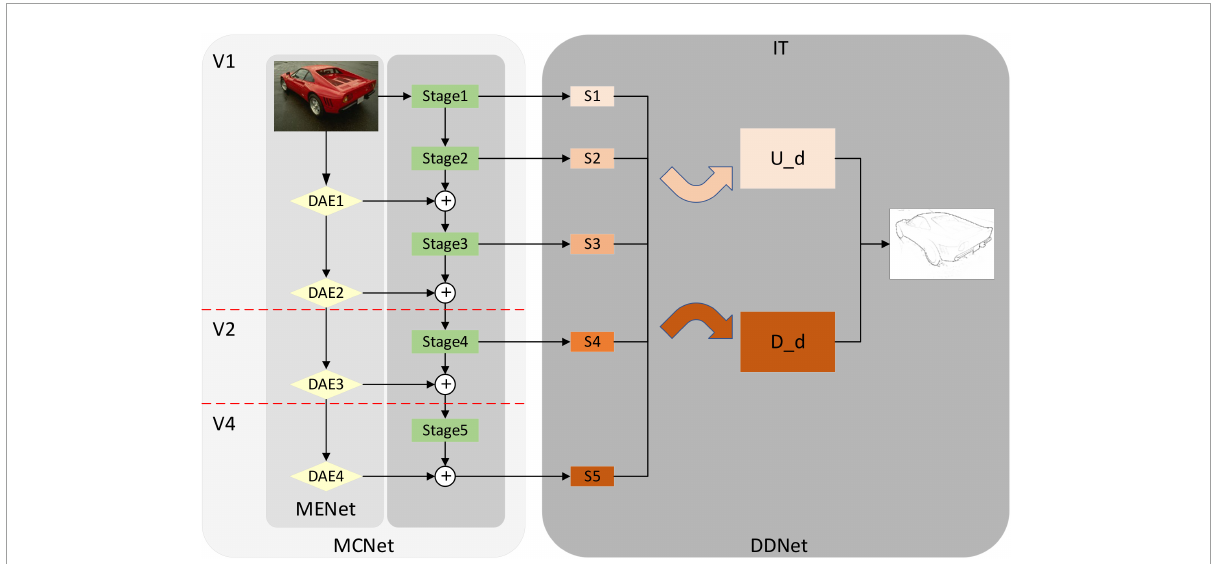
FIGURE2 Overall network structure diagram. From left to right, modulation coding network (MCNet), dual decoding network (DDNet). Among them, MCNet also includes modulation-enhancement network (MENet) (Yellow diamond composition) and coding network (Green rectangle). Down-sampling attention enhancement module (DAE) in MENet is a down-sampling attention-enhancing module designed by using a self-attention mechanism. MCNet corresponds to V1, V2, and V4 in the biological visual pathway. The dual-decoding network DDNet integrates the feature information of up-sampling and down-sampling, respectively and outputs the feature information after integration. DDNet corresponds to the IT layer in the visual pathway. In the following sections, we describe the detailed structure of MCNet, MENet, DAE, and DDNet. Source photos: BSDS500 dataset - publicly available